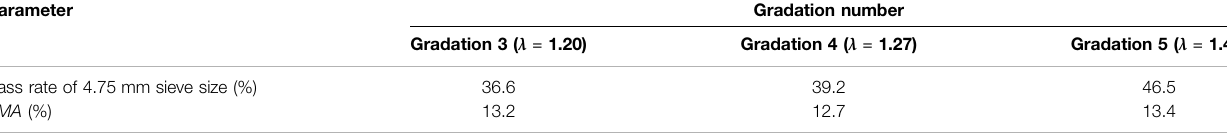
TABLE 3 | Pass rate of 4.75 mm sieve size for each gradation and VMA of HMA